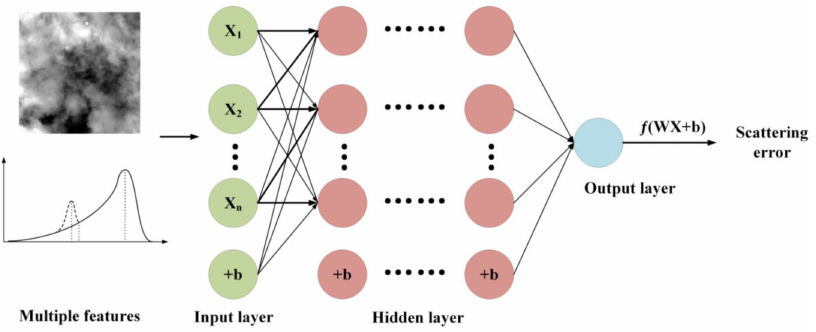
Figure 5. Principle of the multi-layer perceptron (MLP) multiple regression model fitting